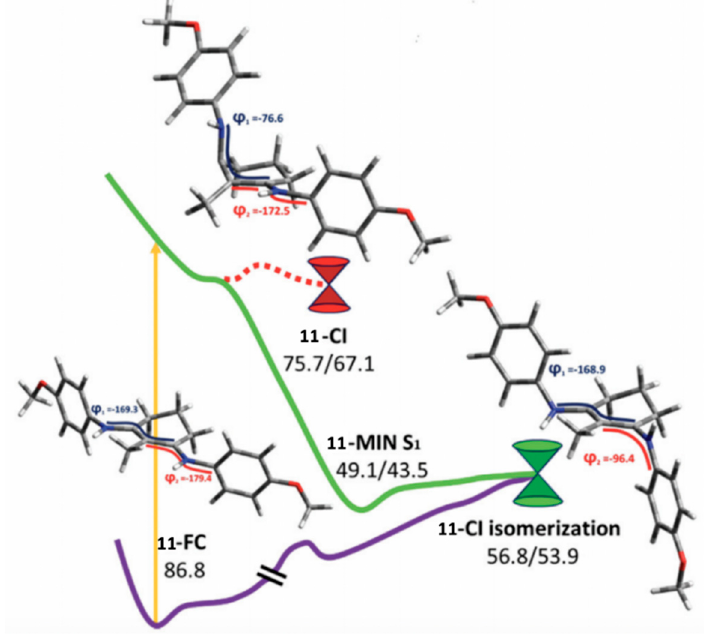
Figure 16. Critical points along the MEP for molecule 11 computed by Losantos et al. [84], where the energies are reported in kcal mol -1 with respect to the electronic ground-state minimum. Where two numbers are present, the first number corresponds to the S 1 energy, and the second number corresponds to the S 0 energy at the specified geometry. Reproduced from [84], with permission from the PCCP Owner Societies.